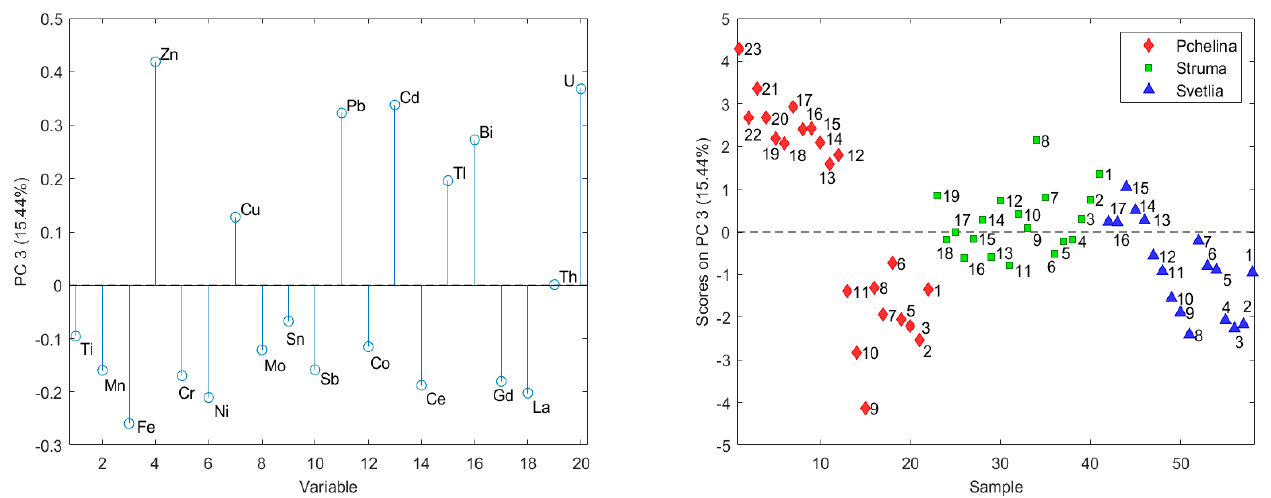
Figure 3. Factor weights and factor scores of the third principal components (the numbers on the graph indicate the historical sequence of layers in sediment core with the first (1) being the oldest).